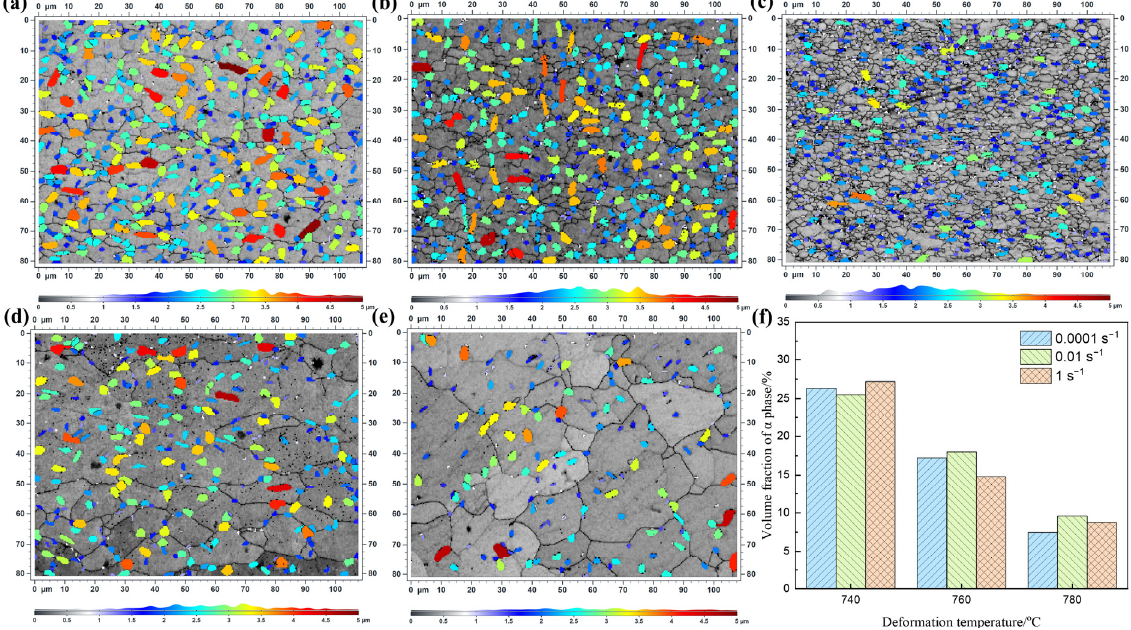
Figure 3. The α grain sizes spread under different deformation conditions: ( a ) 740 ◦ C/0.0001 s − 1 ; ( b ) 740 ◦ C/0.01 s − 1 ; ( c ) 740 ◦ C/1 s − 1 ; ( d ) 760 ◦ C/0.0001 s − 1 ; ( e ) 780 ◦ C/0.0001 s − 1 ; and ( f ) the variation of α volume fraction with deformation